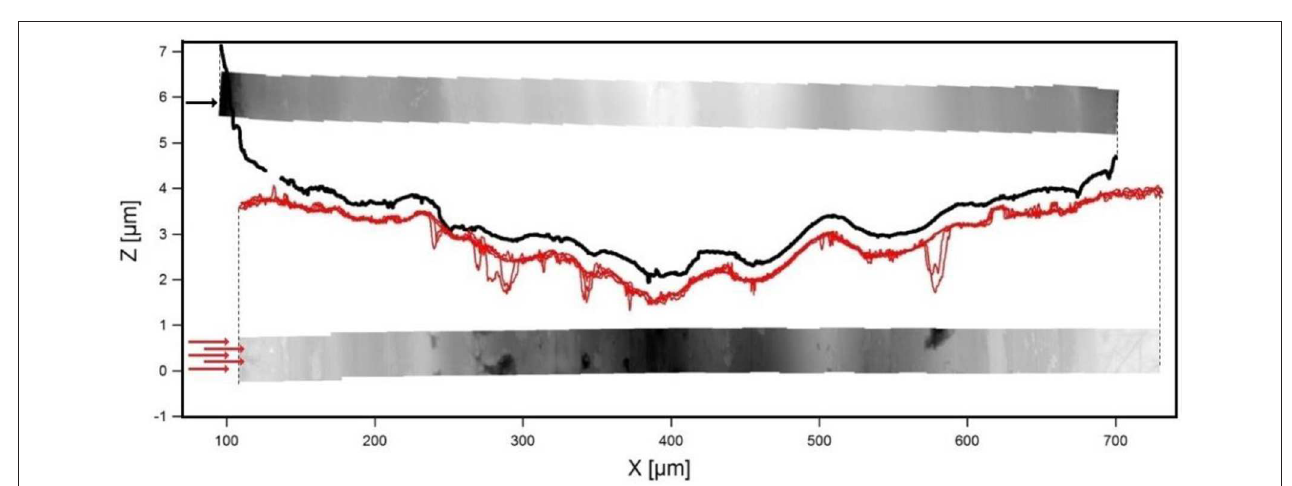
FIGURE 6 | Profile lines perpendicular to the sliding direction of sphere (black thick line at the top) and plane (5 thin red lines at the bottom) with corresponding topography images and arrows indicating the position of the profile lines. The sphere is shown on the top in a gray scale from − 2.6 µ m (white) to 2 µ m (black). The plane is shown at the bottom in a gray scale from − 2.3 µ m (black) to 0.5 µ m (white). The AFM contact topographies were taken in the center of the scars on the sphere and on the